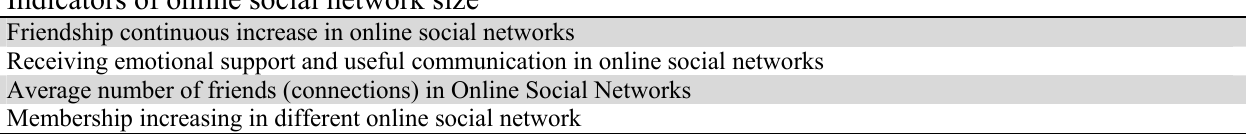
Indicators of online social network size Friendship continuous increase in online social networks Receiving emotional support and useful communication in online social networks Average number of friends (connections) in Online Social Networks Membership increasing in different online social network